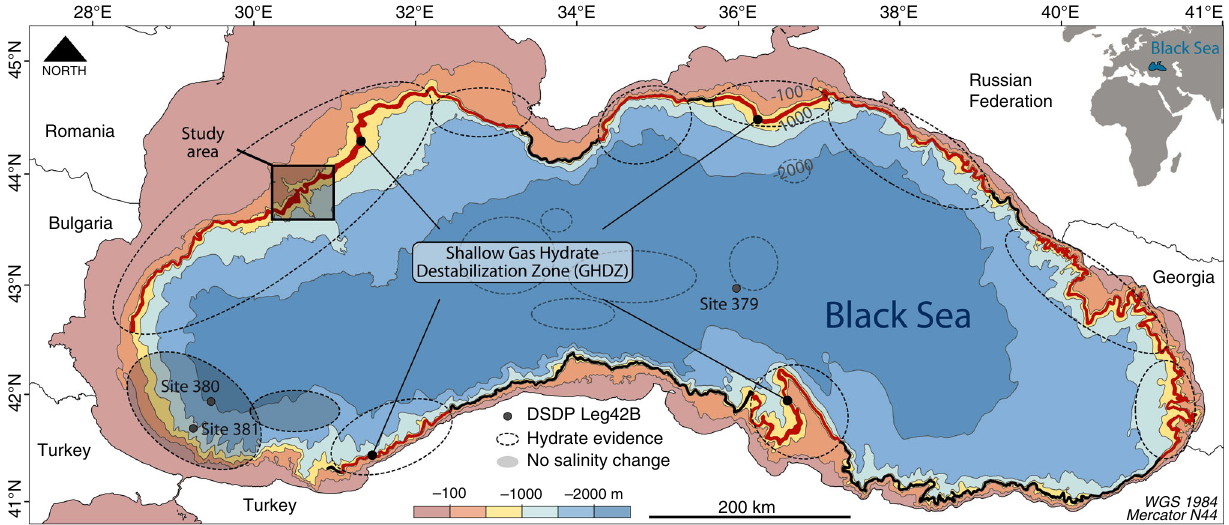
Fig. 5 Gas Hydrate Destabilization Zone potentially covering 2800 square kilometers of the Black Sea margin. The Gas Hydrate Destabilization Zone (GHDZ-the red zone) close to the sea fl oor denotes the area where the GH has been recovered or inferred (see Supplementary Fig. 2 and references in caption) and are expected to decompose due to salinity diffusion through the sediment. The red zone is comprised between the modern and the future (5000 yrs) landward termination of the GHSZ that correspond to the 660 and 720 mbsl bathymetric contours